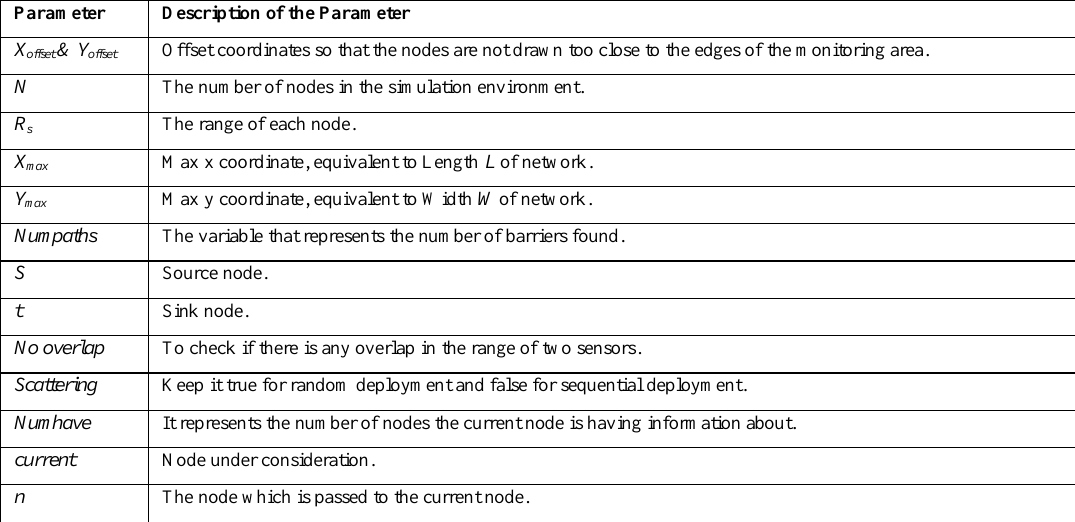
Table 1. Parameters and